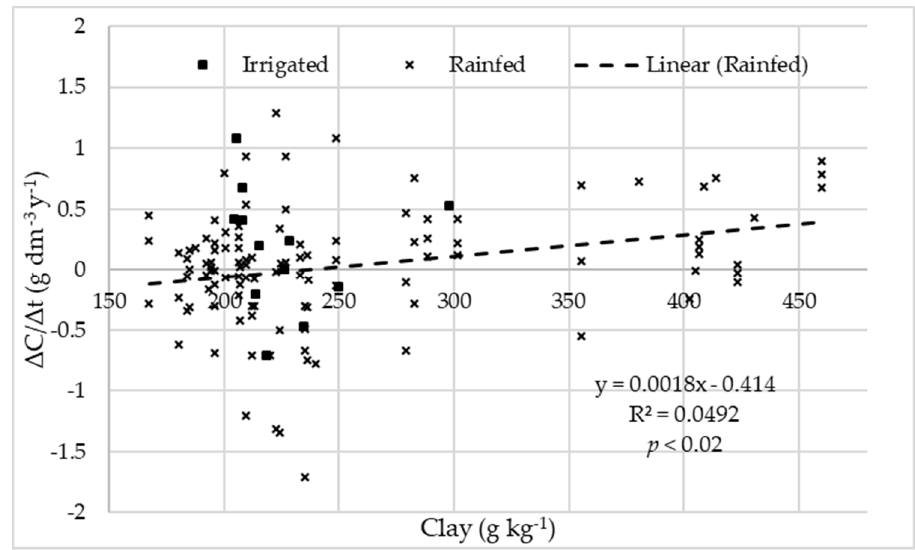
Figure 2. Annual rates of variation of carbon content in the 0.00–0.20 m layer obtained for the irrigated and rainfed agricultural plots according to clay content. The linear regression was calculated only for the rainfed plots.